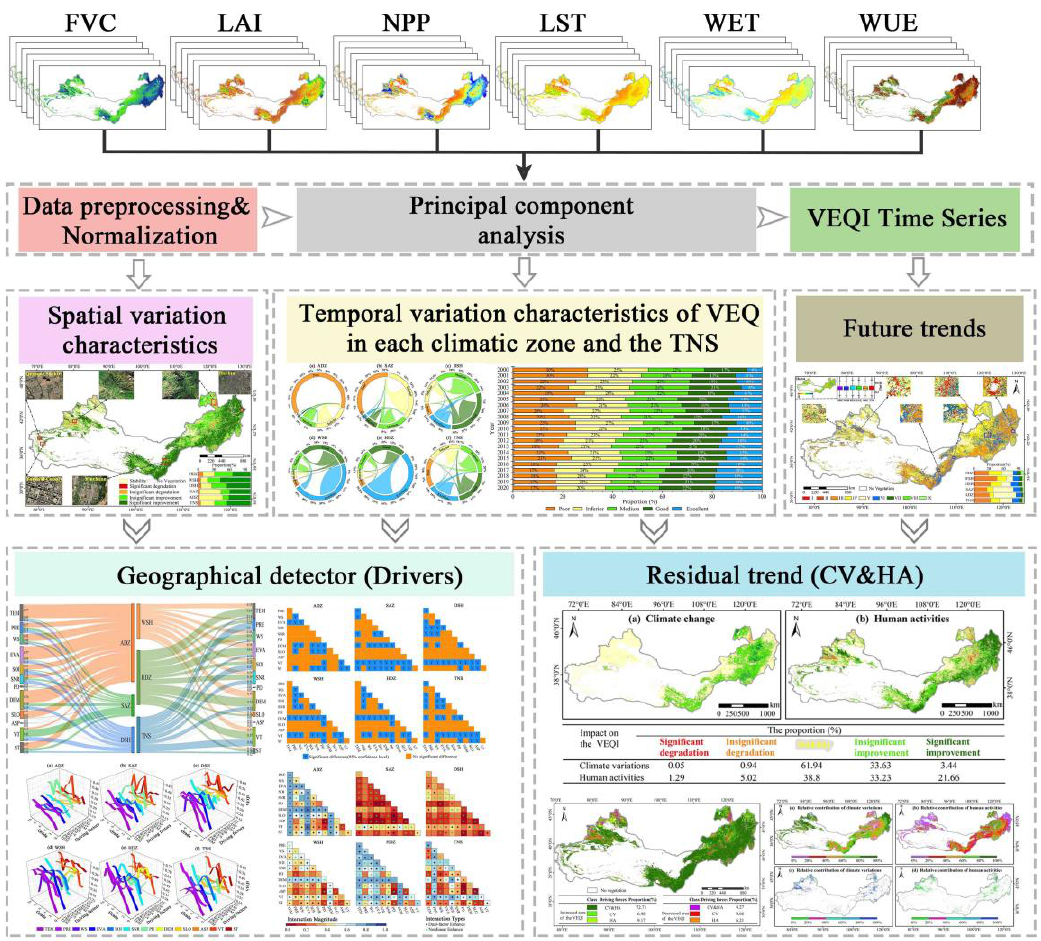
Figure 3. Research flowchart.